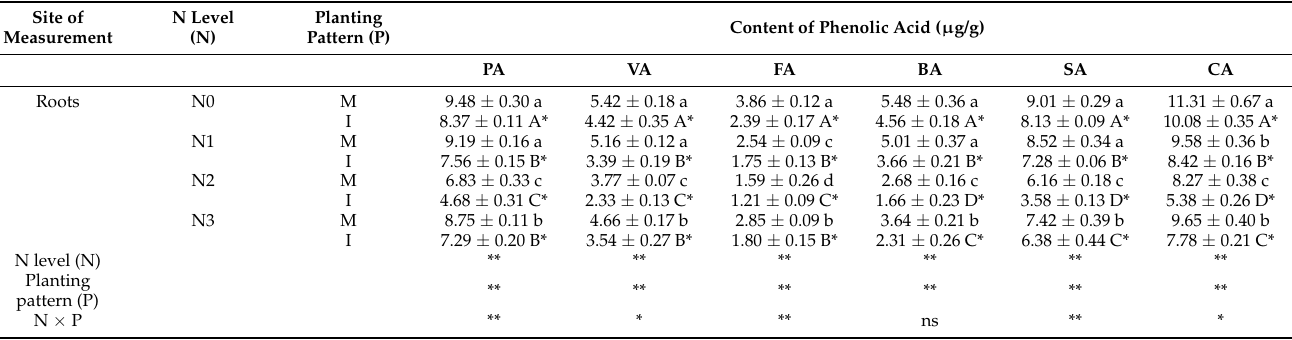
Table 2. Effects of nitrogen application and intercropping on phenolic acid content in faba bean